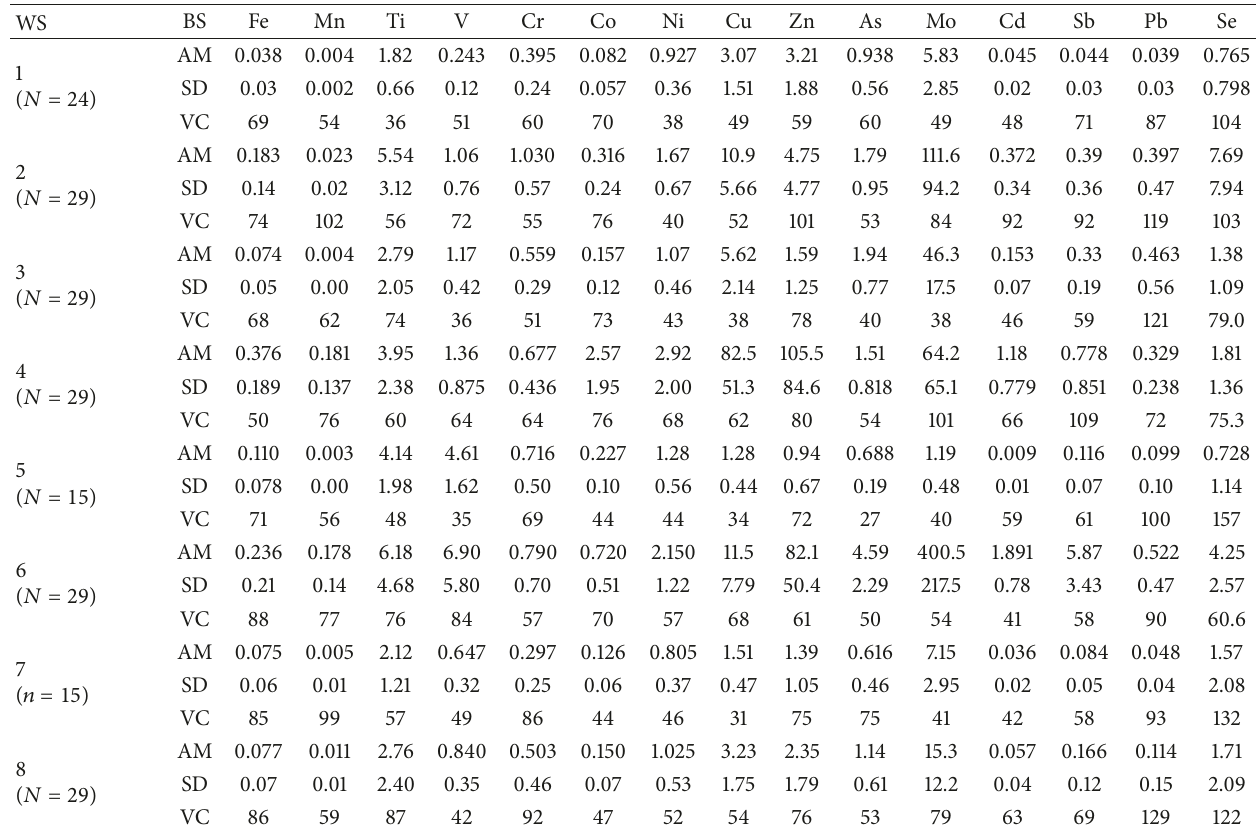
Table 3: Arithmetic mean (AM) concentrations, standard deviation (SD), and variation coefficient (VC %) of heavy metals in waters of Voghji River and its tributaries during the period 2014–2016 (units are 𝜇 g/L, except Fe and Mn for which units are mg/L; 𝑁 represents the number of